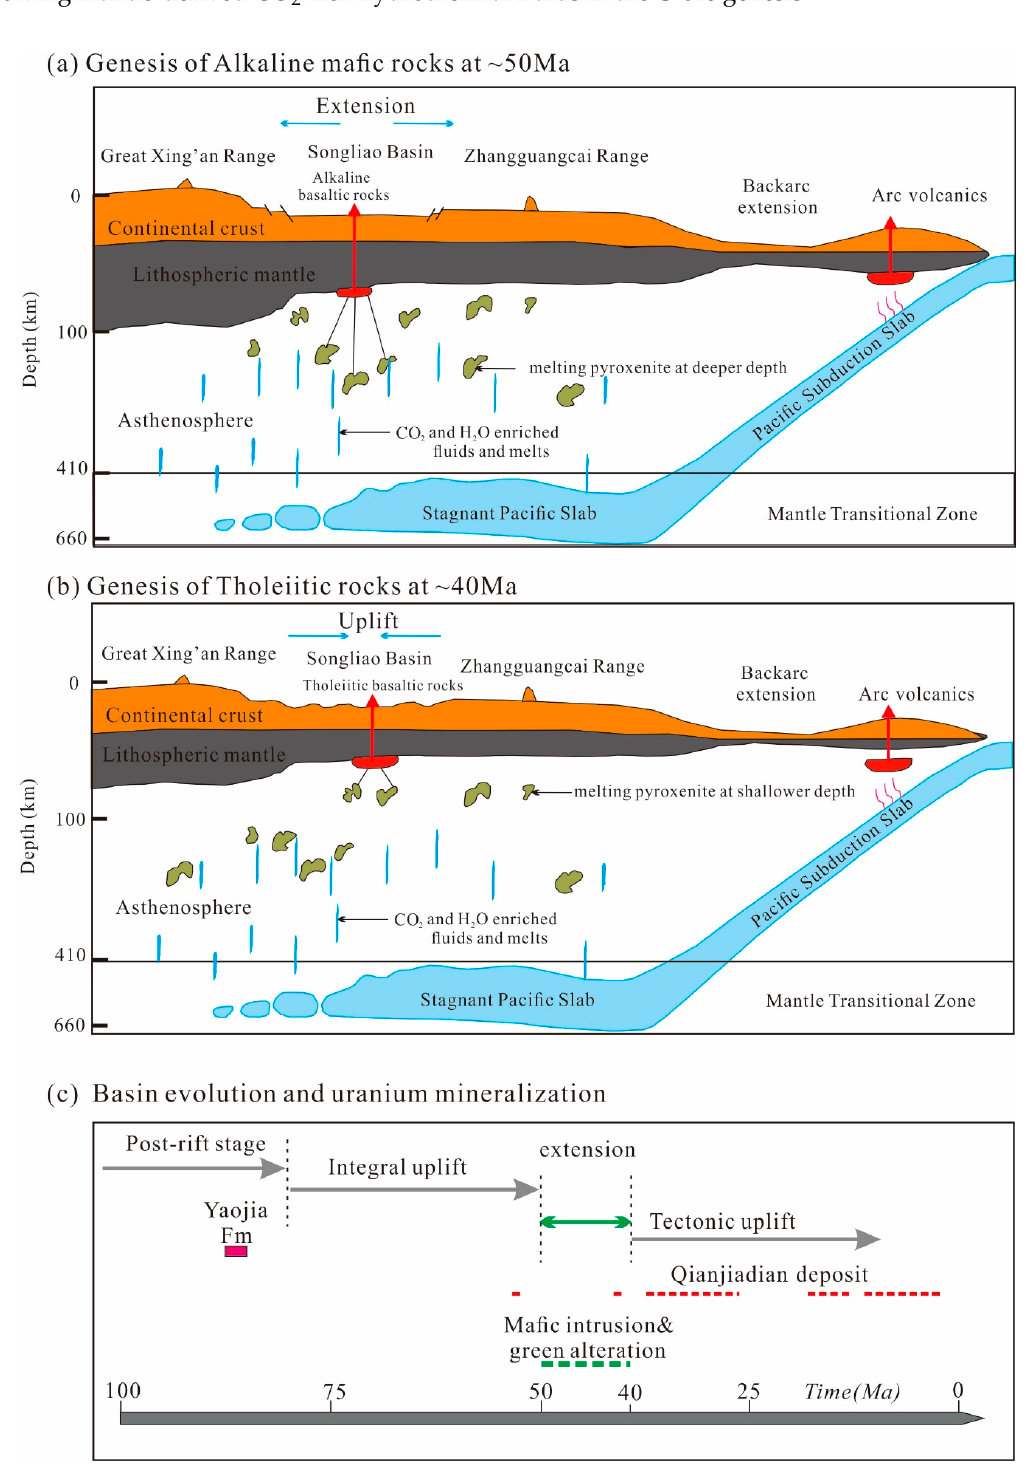
Figure 15. ( a , b ) Petrogenetic model of the Early Cenozoic mafic rocks in Qianjiadian area caused by lithospheric thinning attributed to the subduction of the Pacific Plate, modified from [97]. ( c ) Basin evolution associated with sandstone-type uranium mineralization, modified from